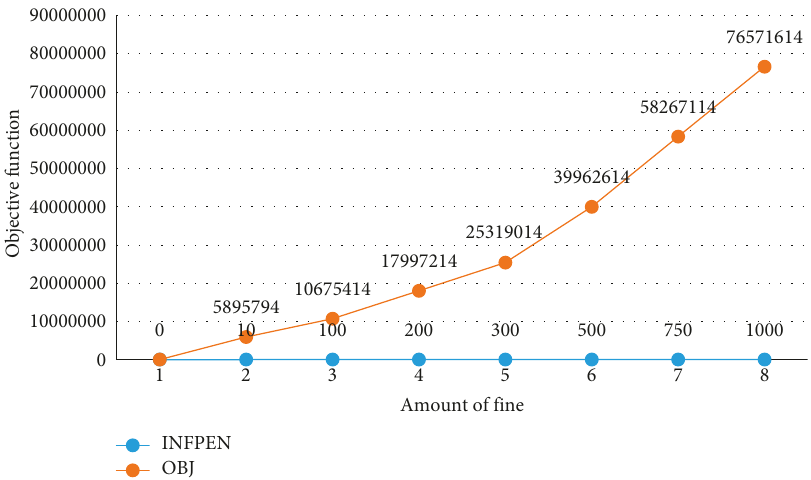
Figure 2: Changes in the objective function relative to the robustness